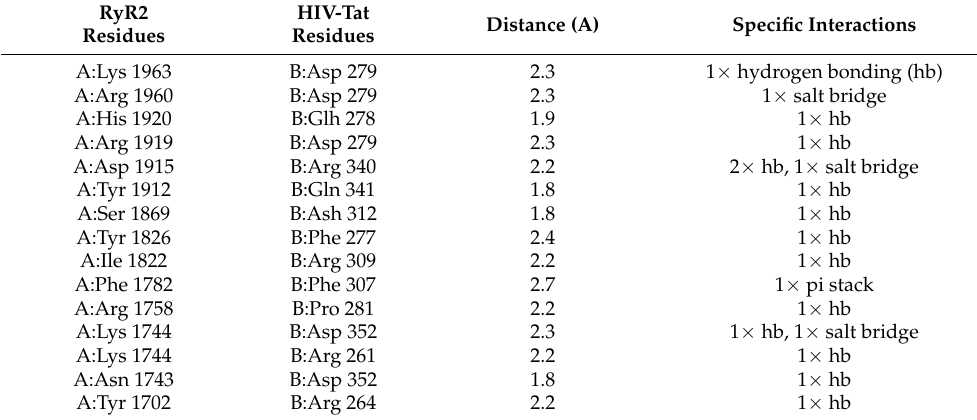
Table 1. Thermodynamically favored interactions between RyR2 and HIV-Tat at site